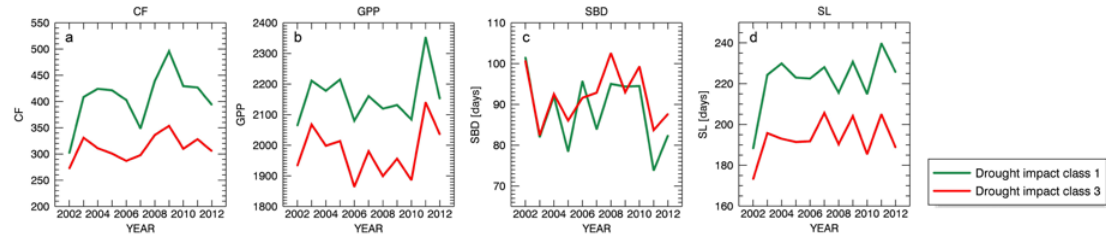
Figure 3. Year-to-year variability observed within the drought impact classes 1 (in green) and 3 (in red) footprints representing respectively, negative and positive correlation to the 4nNDII7 PC: ( a ) CF (Cyclic Fraction); ( b ) GPP (Gross Primary Production); ( c ) SBD (Season Begin Day) and ( d ) SL (Season Length). Significance of class-dependent year-to-year differences was assessed with ANOVA model and is given in Table A2.